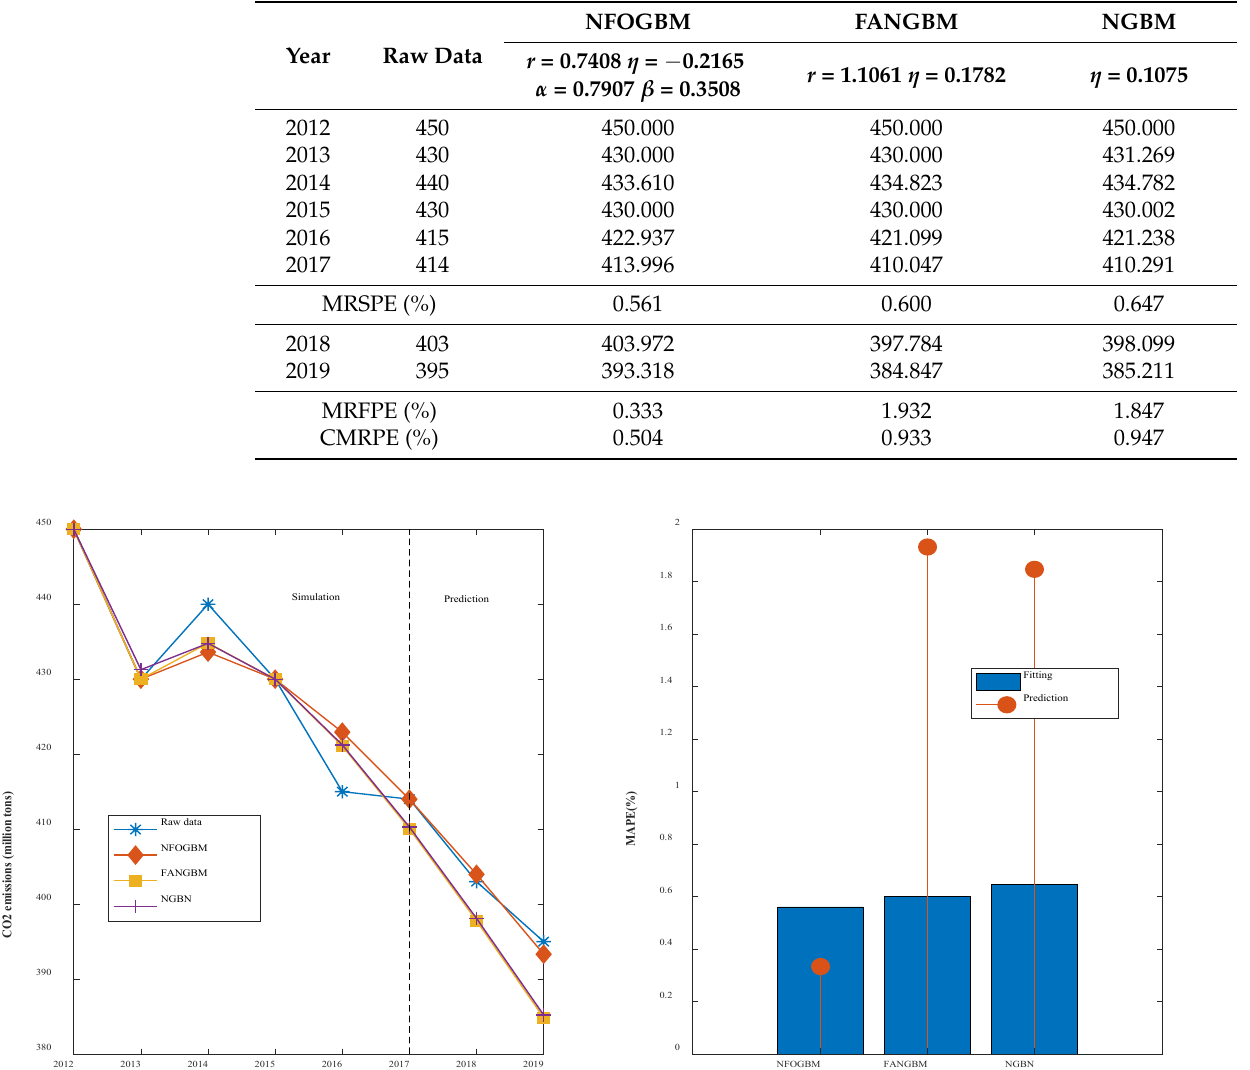
Table 2. Modeling results for WRTCS.